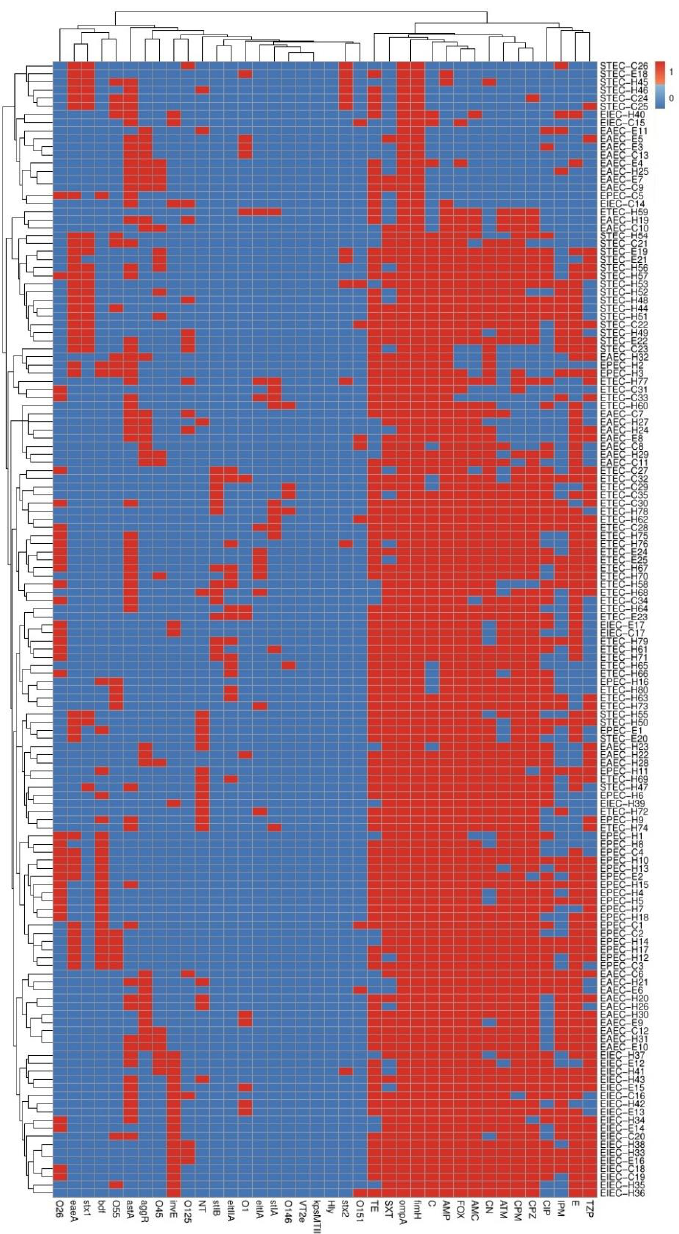
Figure 4. Heat map and hierarchical clustering of diarrheagenic E. coli pathotypes according to the occurrence of serotypes, antimicrobial resistances, and virulence genes. Blue and red colors indicate the sensitivity and resistance to a certain antimicrobial and to the absence and presence of a particular serotype and virulence gene, respectively. The code numbers on the right side of the heat map denote the numbers of diarrheagenic E. coli pathotypes from equine (E), cow (C), and human (H)